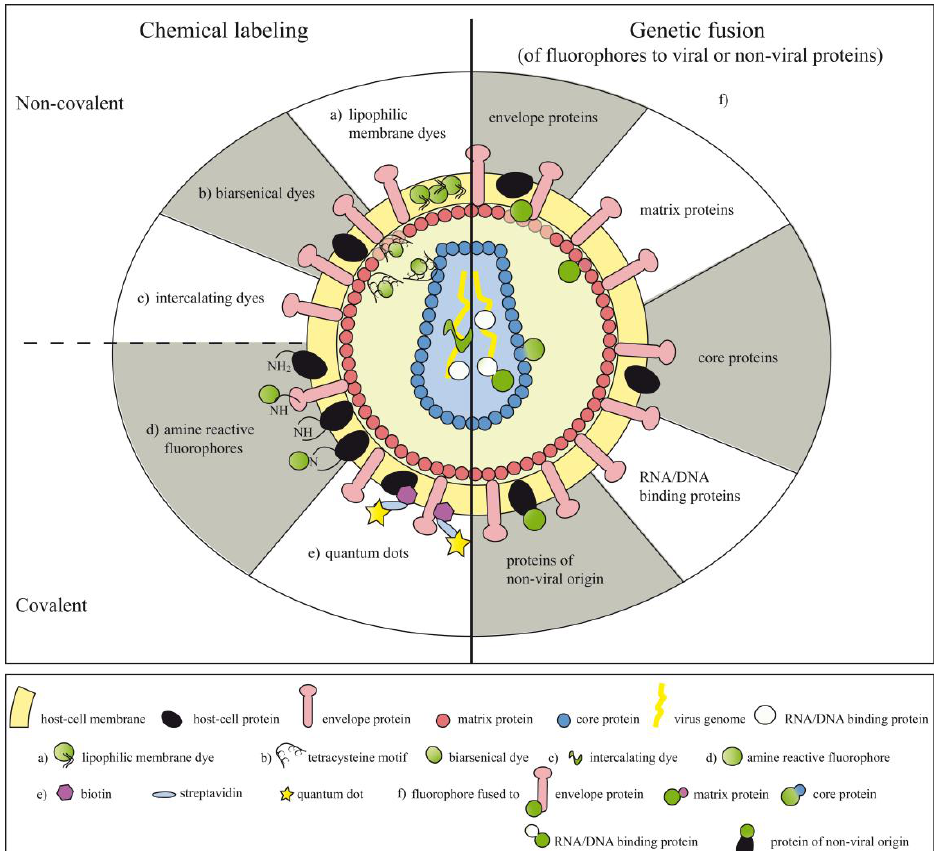
Figure 1. Methods applied for the labeling of viral particles. Viral particles can be labeled by chemical labeling methods (covalent or non-covalent) or by fusion of fluorophores to proteins integrated into the viral particle. Non-covalent labeling of viral particles can be achieved by ( a ) lipophilic membrane dyes inserting themselves into the host-cell membrane, ( b ) biarsenic dyes binding to tetracysteine motifs introduced into viral proteins or ( c ) intercalating dyes interacting with the viral genome. Alternatively, ( d ) amine reactive fluorophores can be covalently attached to proteins present on the surface of the viral membrane. ( e ) Attachment of streptavidin coupled quantum dots can be achieved by biotinylating target structures of interest. ( f ) Fluorophores can be genetically fused to proteins of viral and non-viral